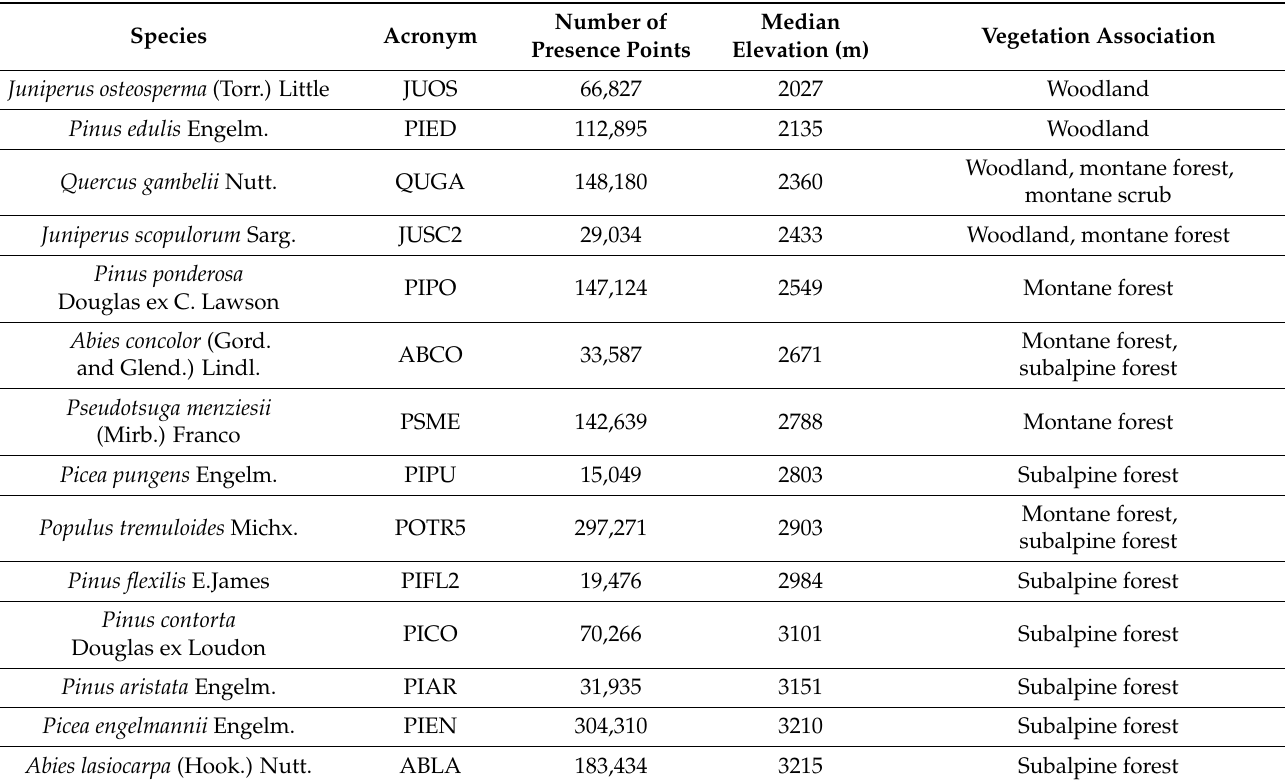
Table 1. Species used in bioclimate modelling, number of point locations recording presence (which is also the number of presence and absence points used in training the model), median elevation of presence data points, and vegetation associations [23] in which the species